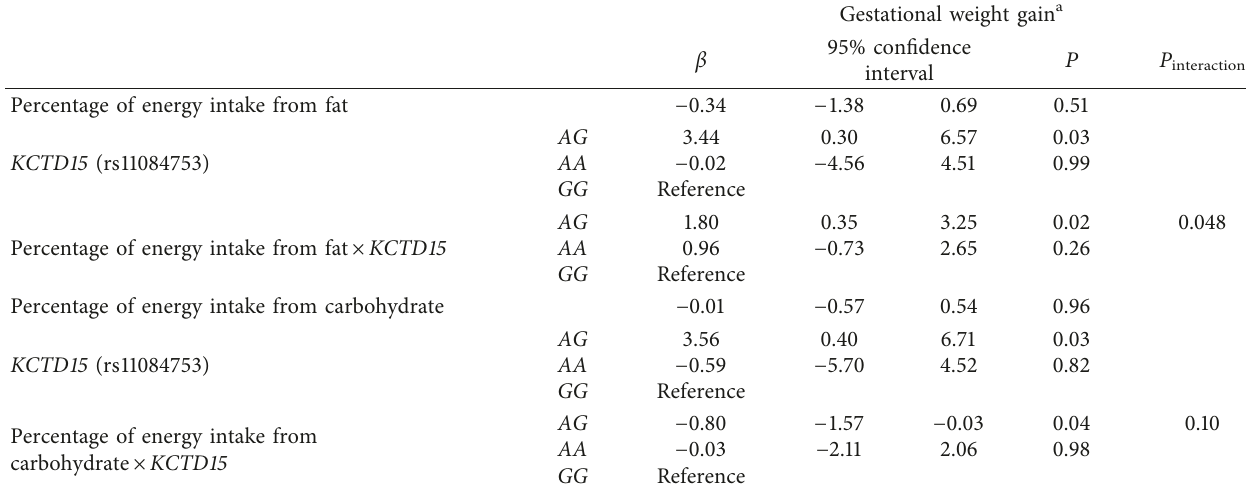
Table 3: The effect of gene-diet interactions on gestational weight